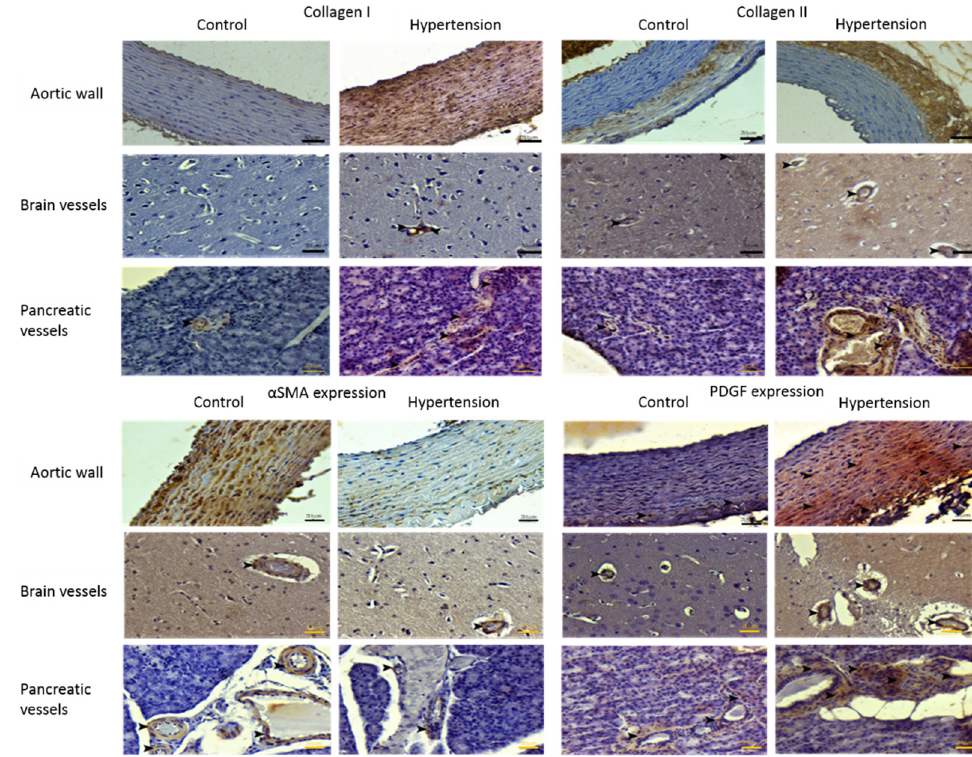
Figure 3. Immunobiological findings are hereby presented. Expression of collagen I in the examined tissues of the control and hypertensive groups (First and second columns, respectively). Severe expression of collagen I in the control aortic tissue and mild expression of this protein in the hypertensive group. Brain vasculature of the control group showed moderate expression of collagen I, compared to mild expression of collagen I in hypertensive parenchymal brain vasculature. For the normotensive controls, pancreatic vasculature expressed moderate collagen I, and mild expression of collagen I in pancreatic vessels of the hypertensive group is observed. Mild expression of collagen III in the aorta of the control group is observed. The hypertensive aortic tissue expressed type III collagen severely. Additionally, mild expression of collagen III was observed in the brain and pancreatic vasculature of the control group, and the hypertensive group demonstrated moderate collagen III expressions in the brain and pancreas. Differences in α SMA expression in the control and hypertensive groups were more noticeable in the aorta; the control group expressed α SMA severely, and the hypertensive group showed only mild expression. Brain and pancreas vasculature from controls showed moderate levels of α SMA expression, while the respective hypertensive group showed mild expression. For panels representing PGDF expression, arrowheads denote locations of focal expressions. Mild PDGF expression in outer regions of the aortic media for the control group against the severe expression of mentioned growth factor throughout the hypertensive aortic media was noticed. Additionally, for the brain and pancreatic vasculature, mild expression of PDGF in control and severe expression in the hypertensive group were noted. Black arrowheads are used to mention intended expression sites. IHC-P, Bar: 20 μ m.